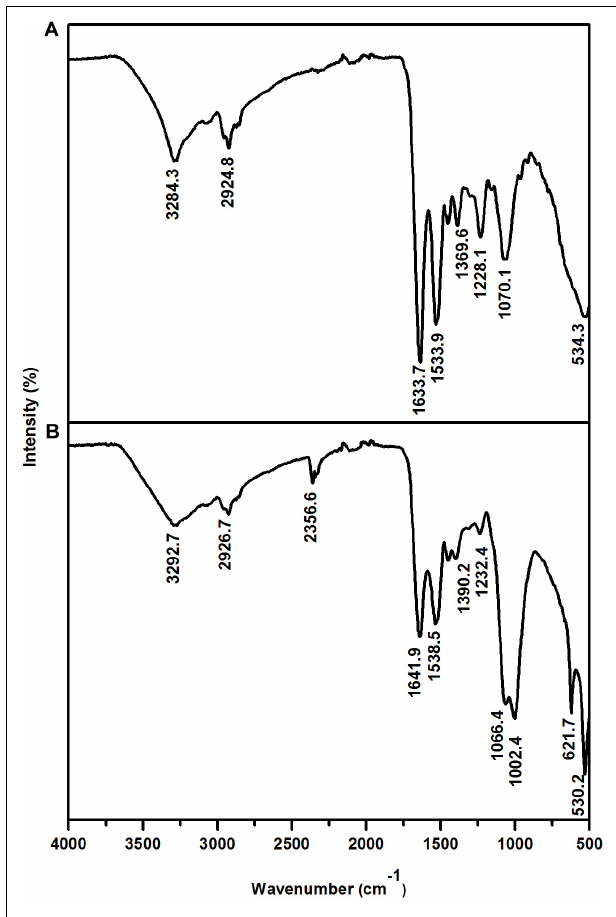
FIGURE 5 | Fourier transform infrared spectrum of T. scotoductus SA-01. Control (A) and cell cultures supplemented with Eu (B) .